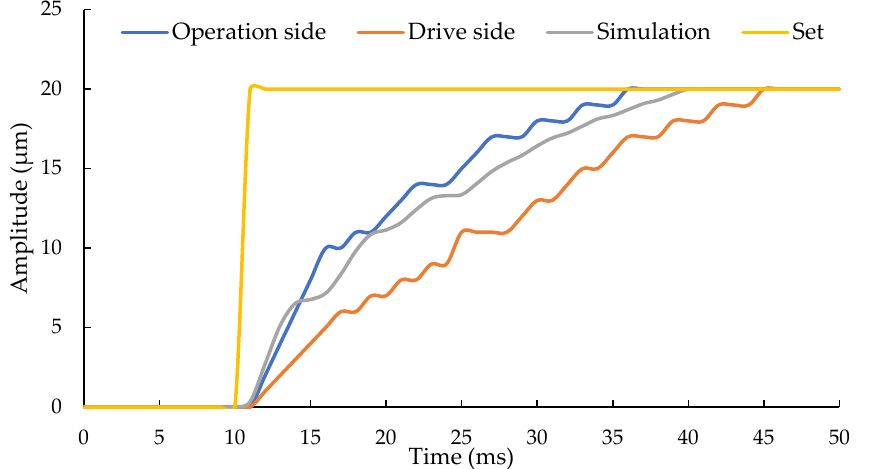
Figure 6. Step response curve of simulation model and factory test.